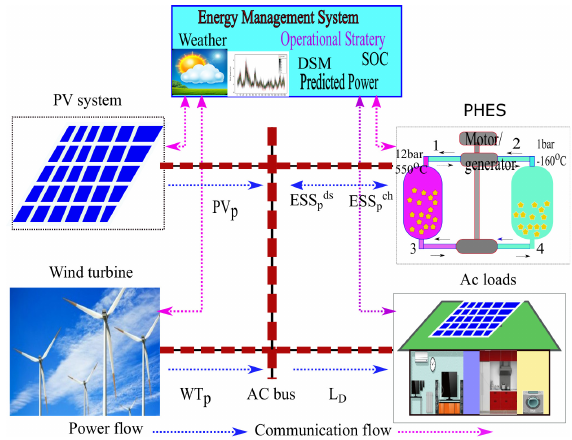
Figure 1. Proposed system